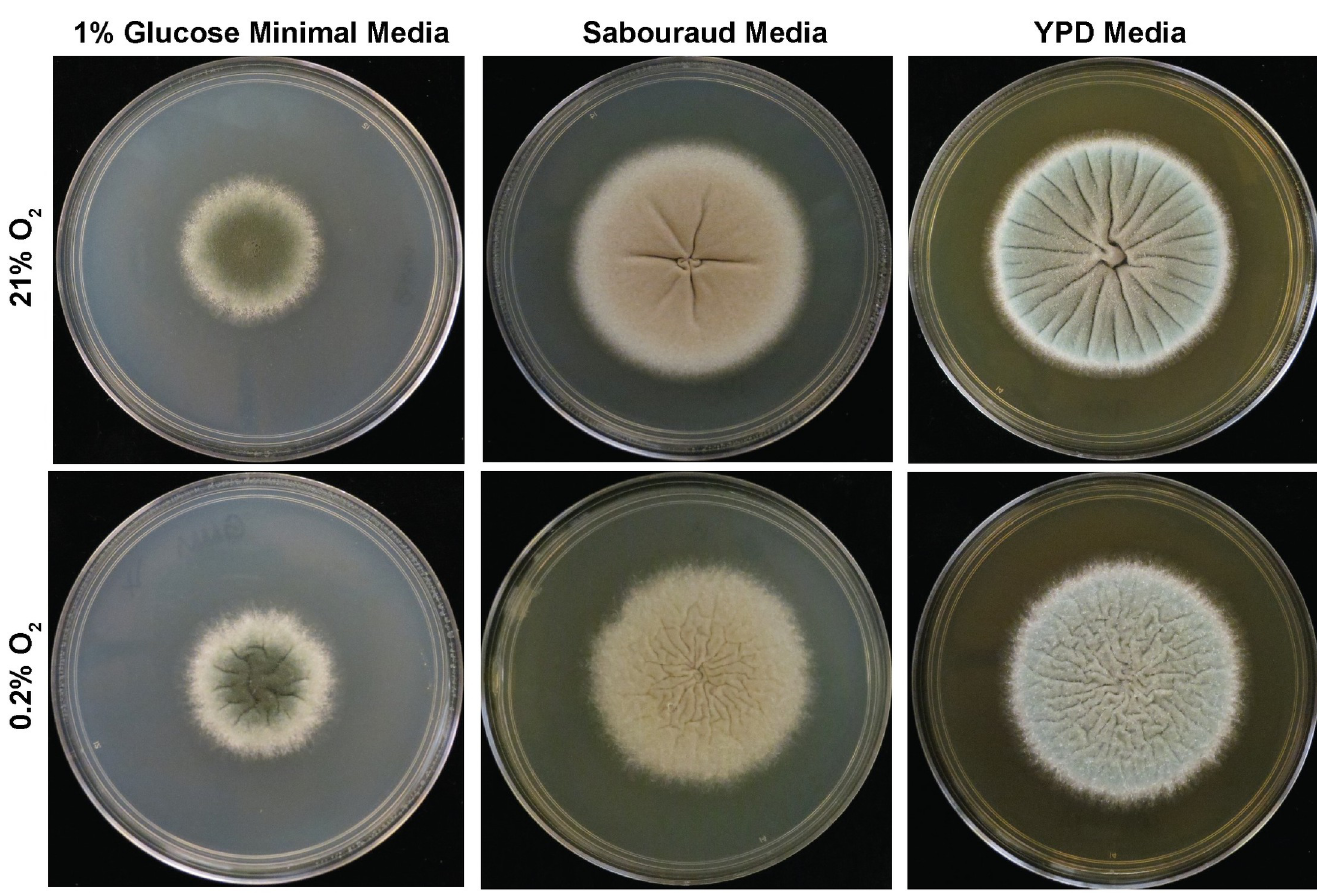
Fig 1. A . fumigatus strain AF293 cultured on minimal and complex media for 72 hours. Representative images of 1,000 AF293 conidia spot-inoculated on 1% glucose minimal media, Sabouraud complex media, or YPD complex media. For each media type, hypoxia exacerbates colony topographical features. Growth on complex media sources results in colony furrows, whereas growth on minimal media does not under the same atmospheric conditions. YPD, yeast peptone